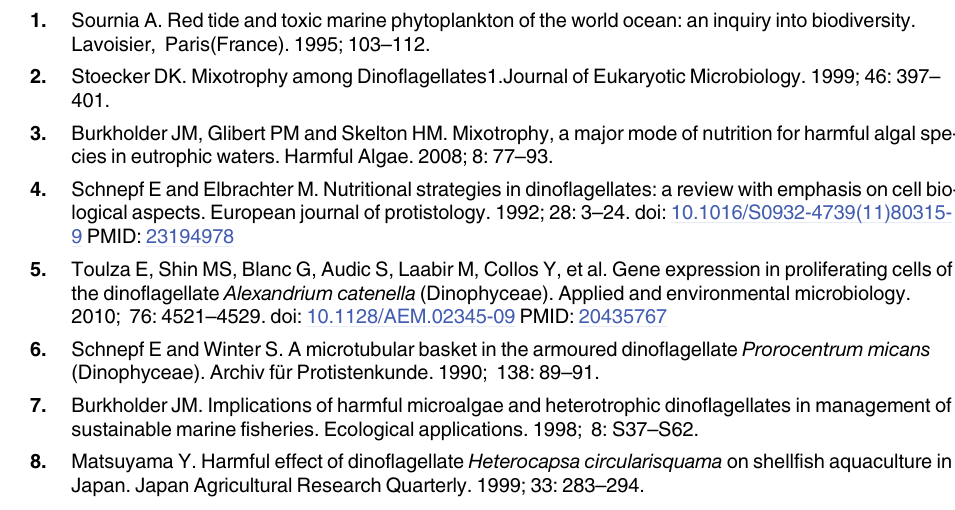
S3 Table. The results of predicted target genesof 12 differentially expressed miRNAsin A . catenella . In total, 1813 target genes were